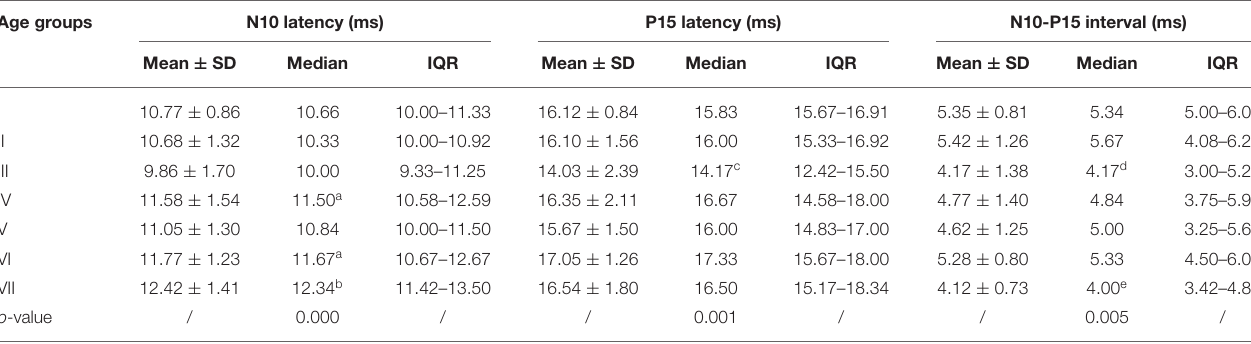
TABLE 5 | The latencies and N10-P15 interval of B81-oVEMP with increasing age. Age